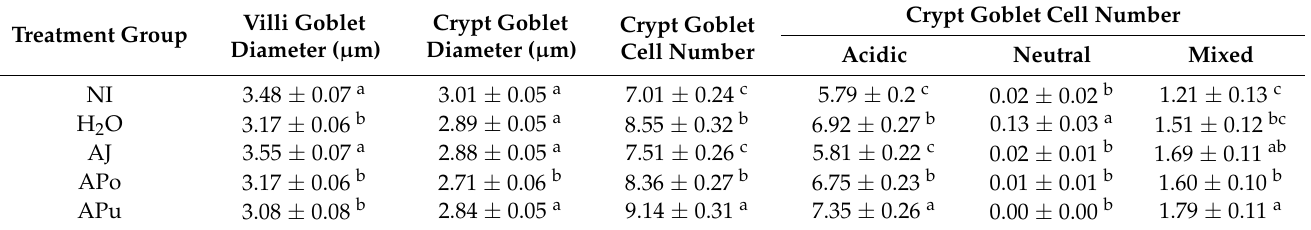
Table 5. Effect of the intra-amniotic administration of apple fraction soluble extracts on villi and crypt goblet cells.